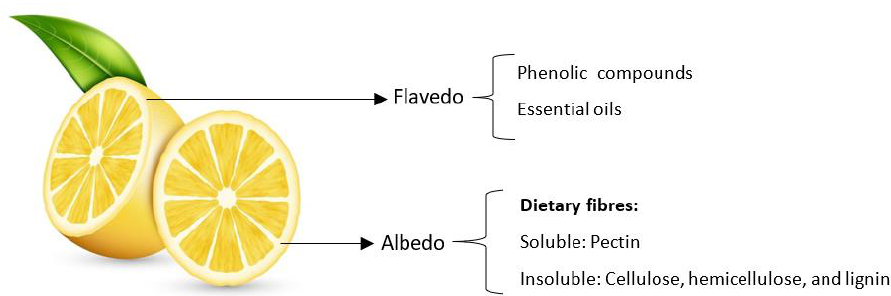
Figure 1. Schematic view of the main structural composition of C. limon peels.